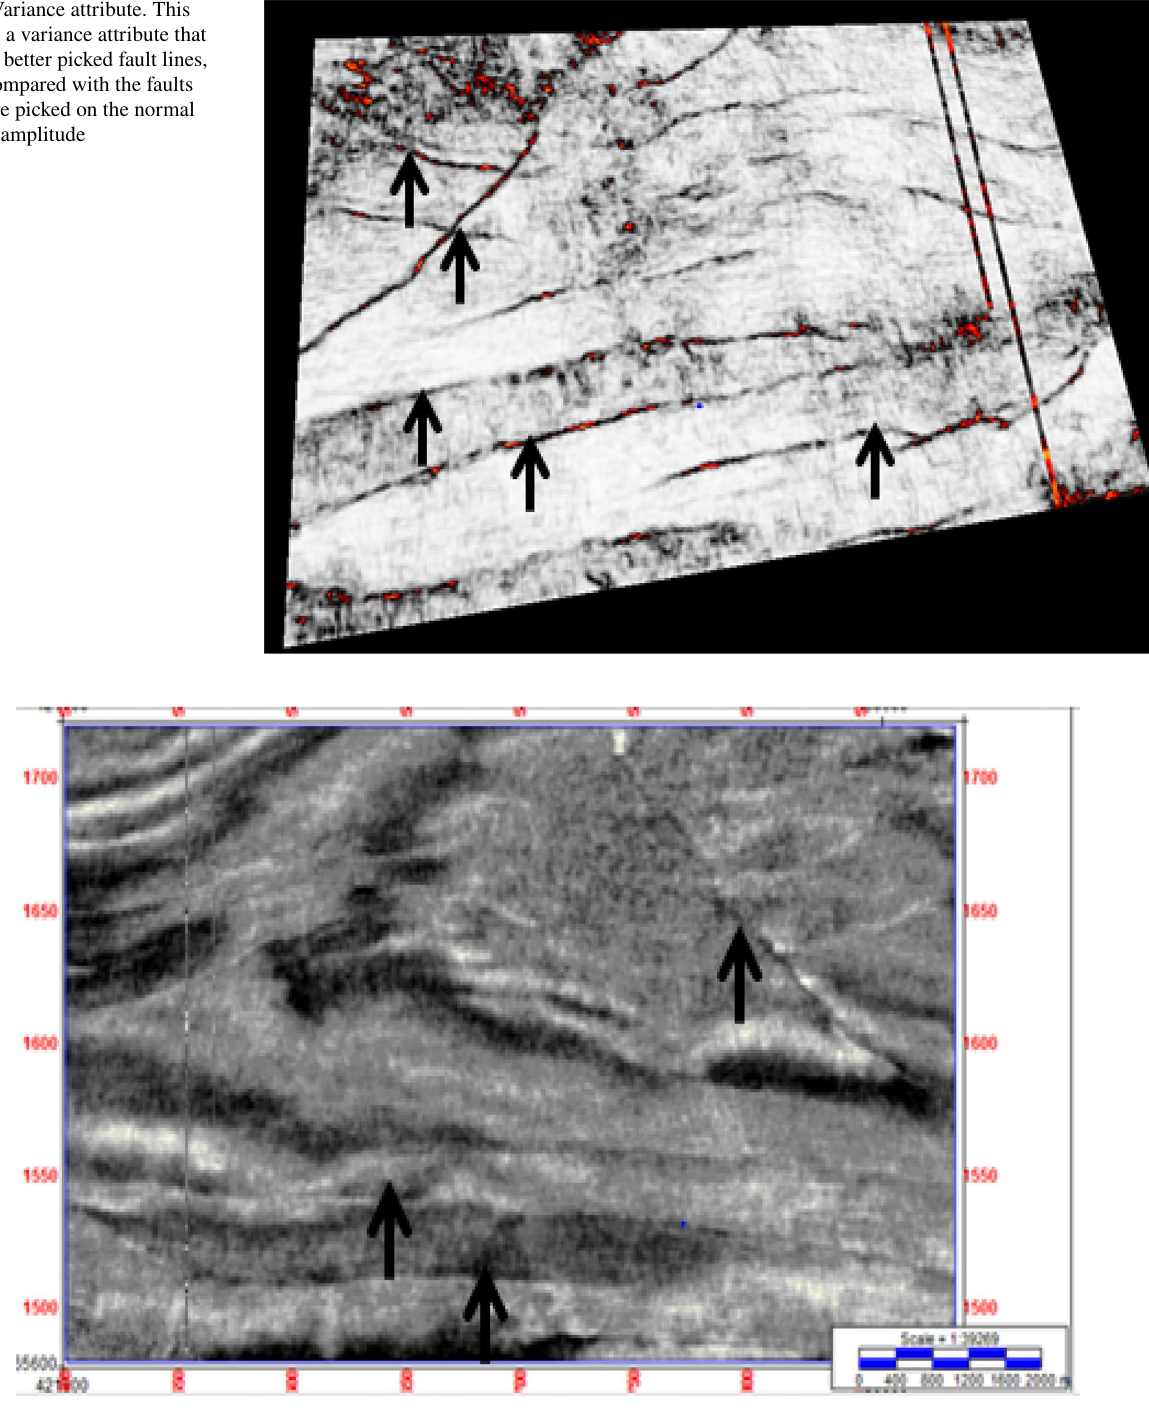
Fig. 8 Coherence attribute. This figure shows the coherence attributes, indicating the picked fault After faults and horizon picking on seismic volumes, the hydrocarbon entrapment there. It can be deduced that the extracted information was posted on the base map, to gen- trapping mechanism in the study location is both an anticli- erate seismic maps. Figures 9 and 10 show the time and nal and fault-supported closure. depth of structural maps of the study location that reveal the 1 3